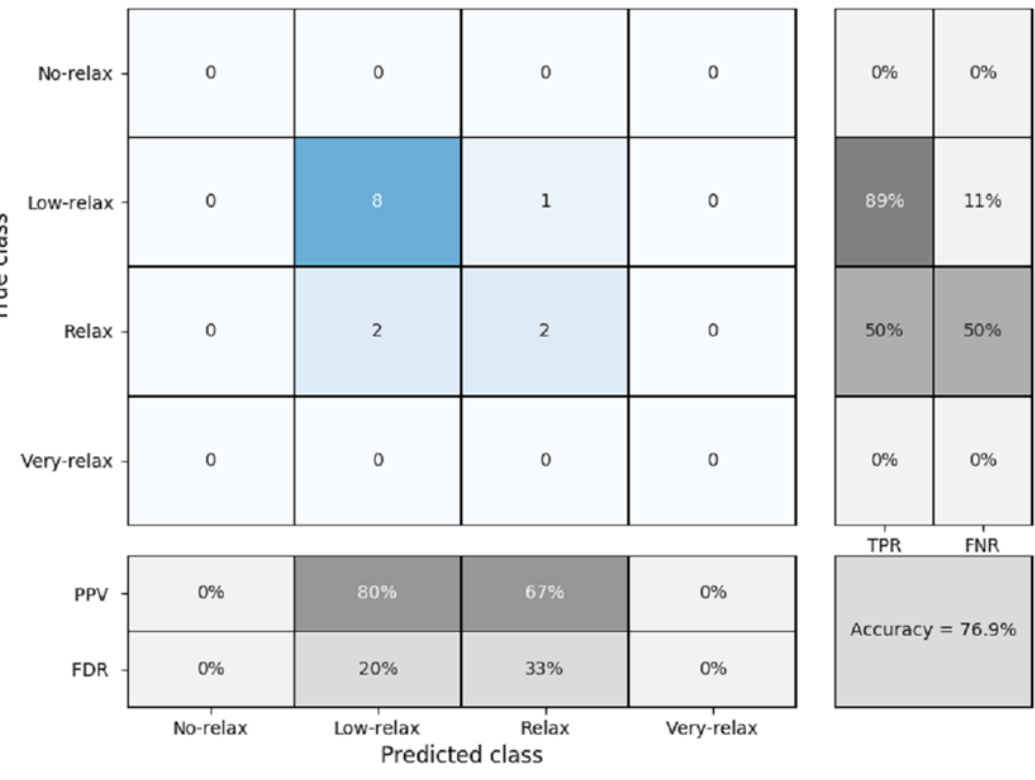
Figure 14. Confusion matrix for k-nearest neighbors (K-NN) classification and five-fold cross validation (girls), where PPV = positive predicted value, FDR = false discovery rate, TPR = true positive rate or sensitivity, and FNR = false negative rate or specificity.